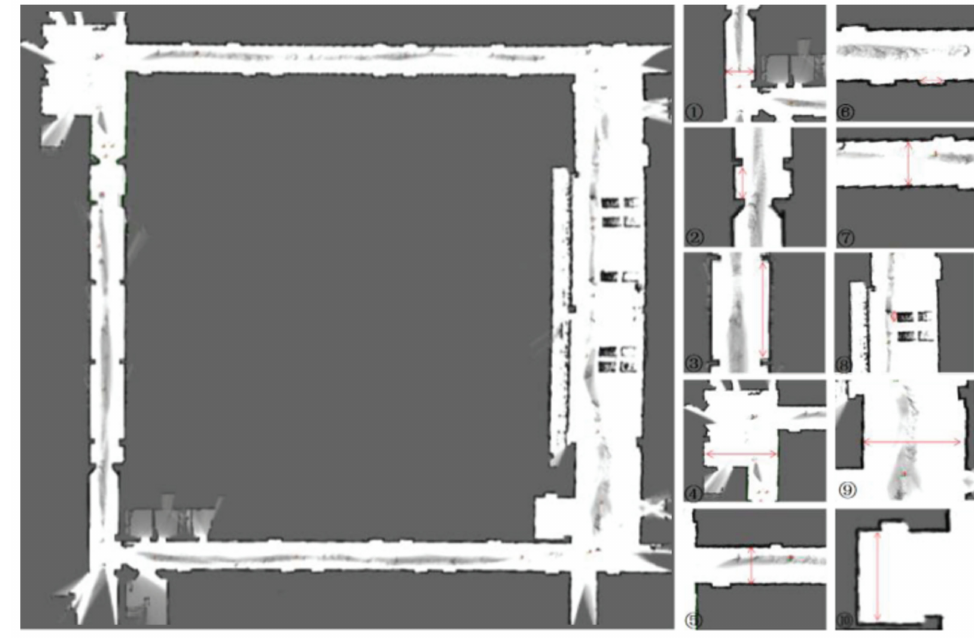
Figure 13. Mapping effect of Cartographer.